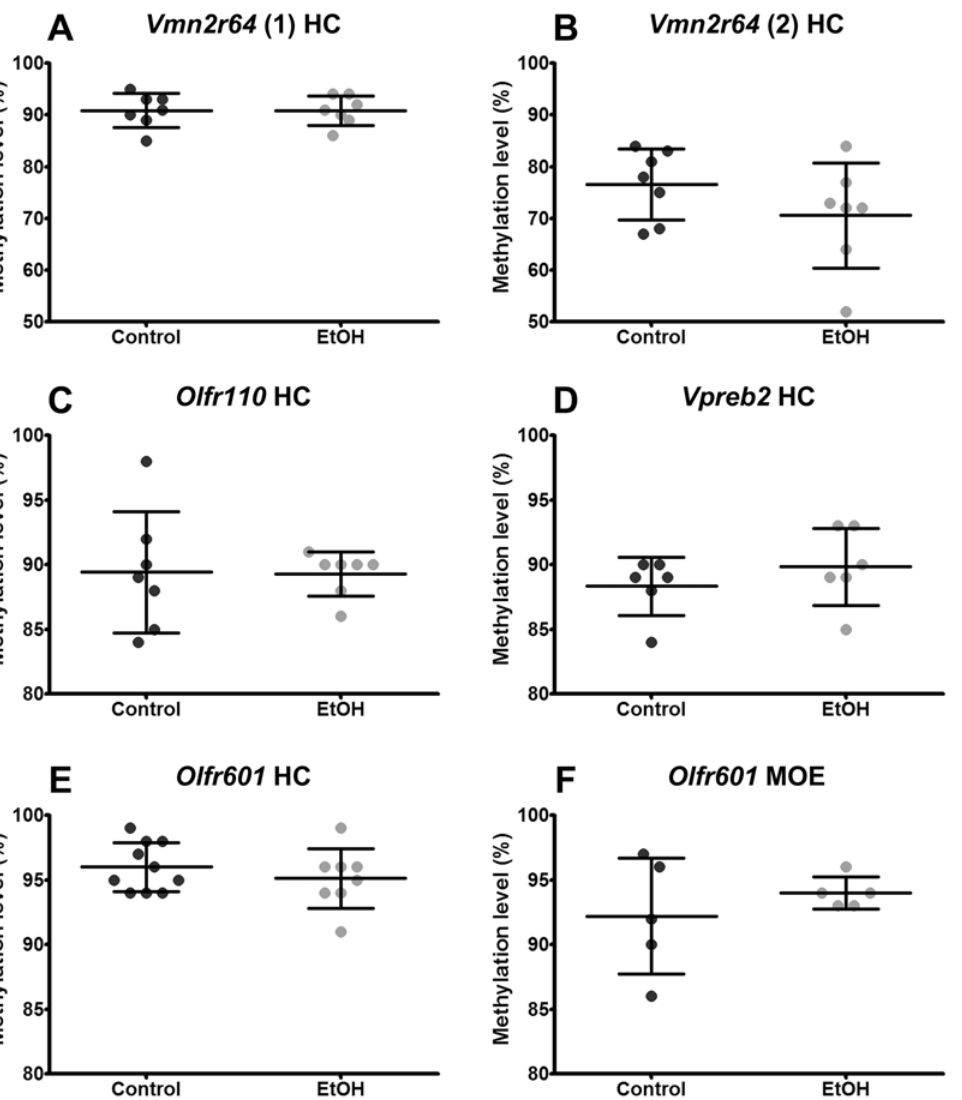
Fig 3. DNA methylation levels of CpG islands of five candidate genes in control and ethanol-exposed offspring. DNA methylation levels of CpG islands in Vmn2r64 [A: upstream CpG island (1) and B: CpG island in gene-body (2)], Olfr110 (C, upstream), Vpreb2 (D, in gene-body), and Olfr601 (E, in gene-body) in hippocampus (HC) and Olfr601 (F, in gene-body) in main olfactory epithelium (MOE). Each dot represents an average of methylation percent of clones in a particular CpG island from individual control or ethanol-exposed (EtOH) male offspring (P28).